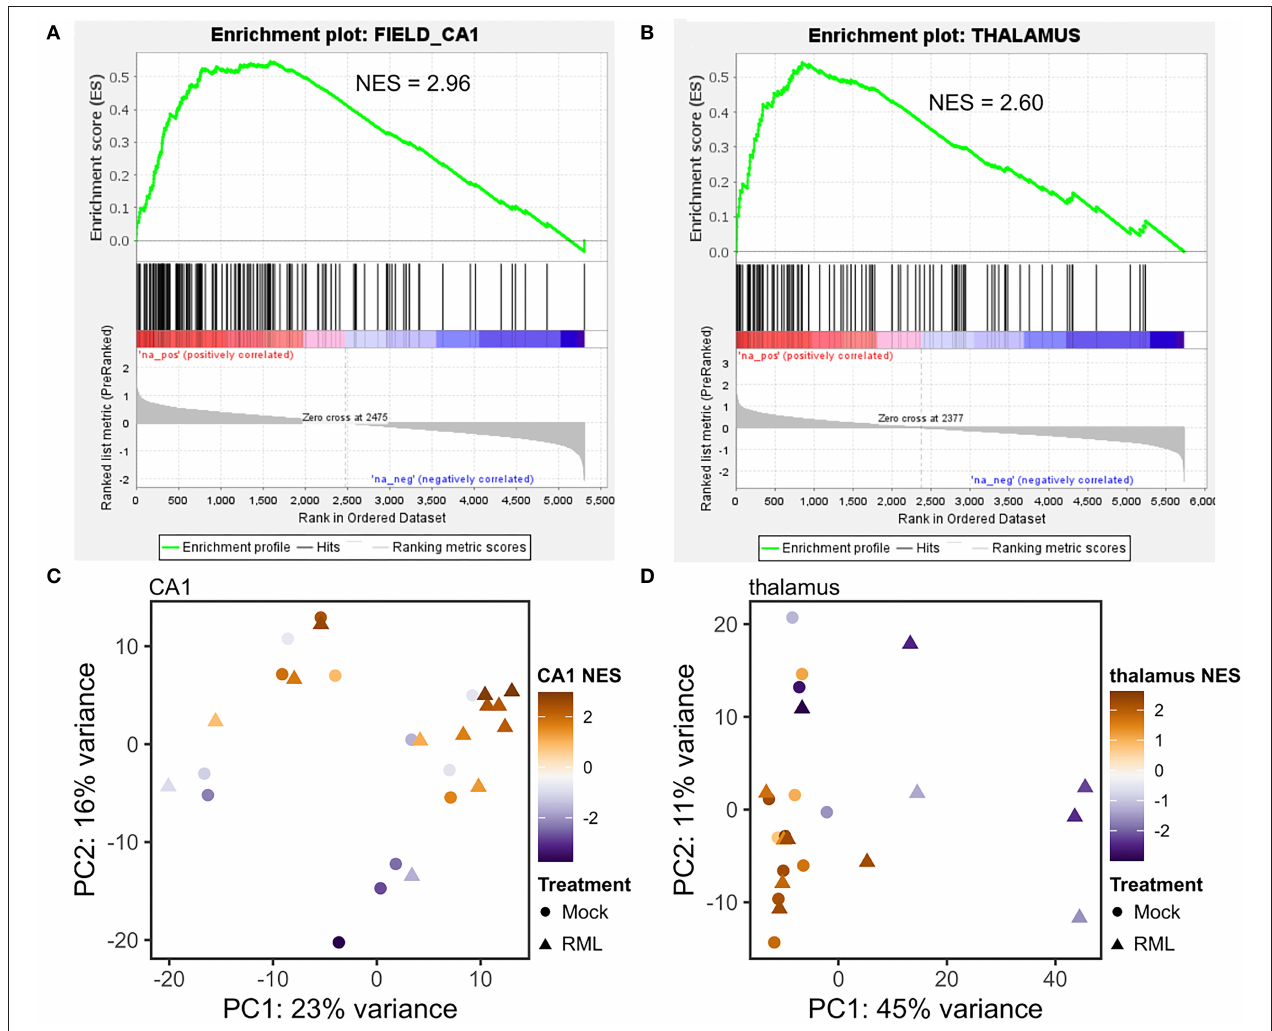
FIGURE 2 | Enrichment with known gene expression profiles from the Allen brain atlas correlates with principle component analysis of microdissected CA1 and thalamus tissues. Gene expression in each microdissected sample from the CA1 or thalamus was ranked based on relative abundance and supplied to GSEA for pre-ranked gene set enrichment analysis against a database of known brain-region enriched genes obtained from the Allen brain atlas. Representative enrichment plots are shown for the CA1 (A) and thalamus (B) . Normalized enrichment scores (NES) for either the Allen brain atlas “CA1” or “thalamus” gene sets were found to correlate with principle component analysis of gene expression in microdissected tissues from the CA1 (C) and thalamus (D) .